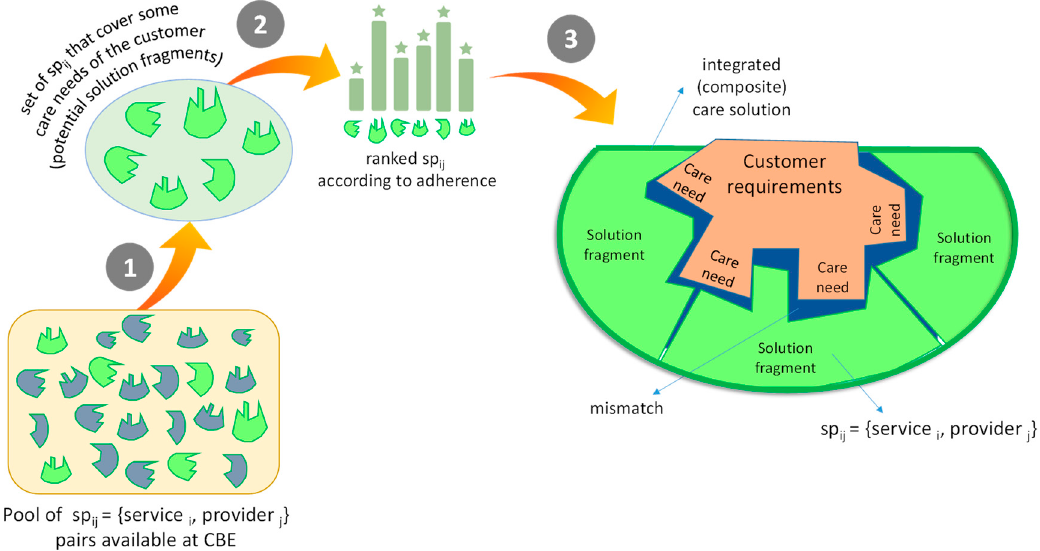
Figure 5. Steps in service selection and Figure 5 . Steps in service selection and composition.